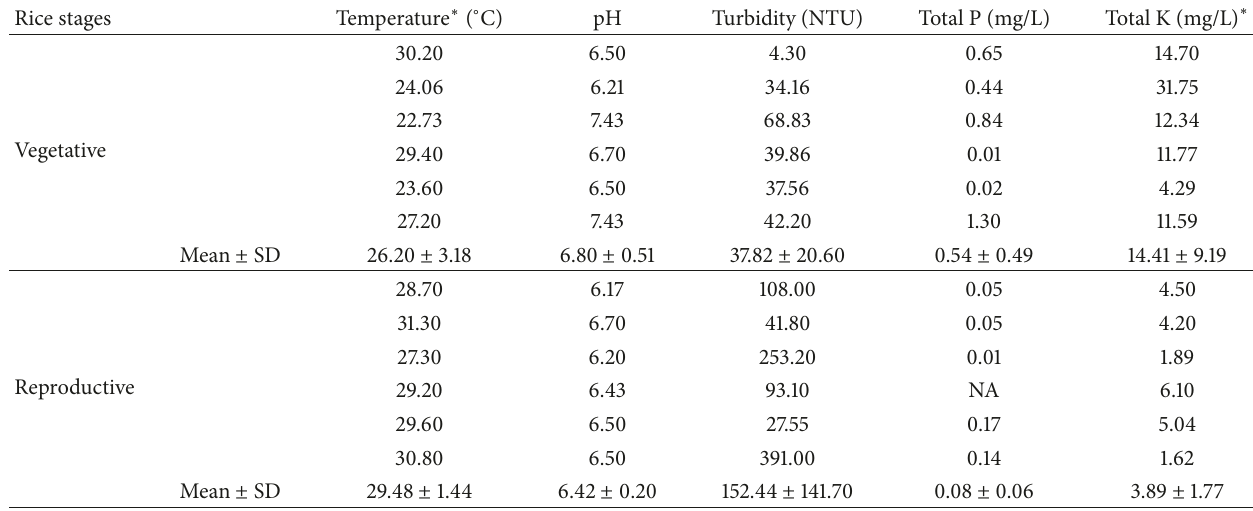
Table 1: Mean values and corresponding standard deviations, for the physicochemical parameters measured in the water samples in relation to the rice stages.